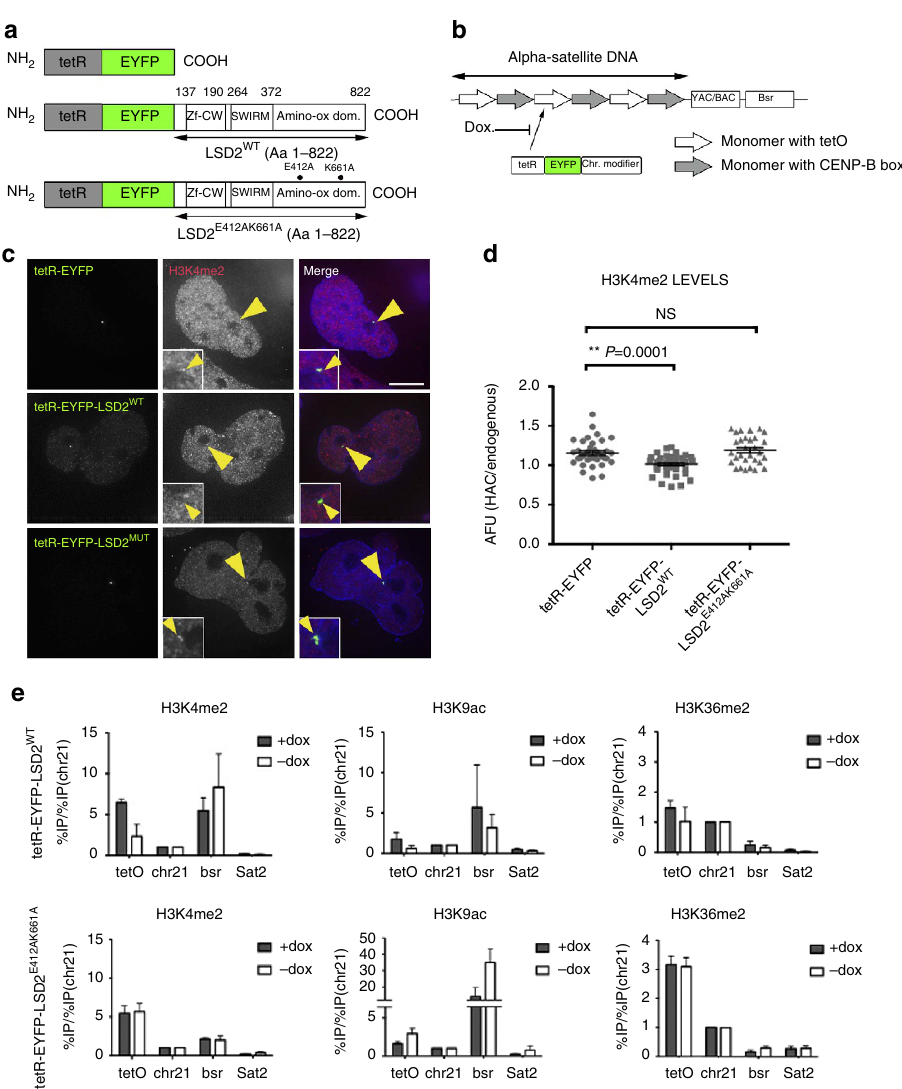
Figure 1 | Tethering LSD2 to the alphoid tetO HAC decreases the H3K4m2 levels. ( a ) Schematic drawings of the tetR-fusion constructs. ( b ) Schematic of the alphoid tetO DNA array, derived from Nakano et al. 27 . ( c ) Immunofluorescence images of 1C7 cells expressing the indicated tetR-fusion proteins and staining for H3K4me2. Arrowheads depict the HAC as determined by the EYFP signal. Scale bar, 10 m m. ( d ) Quantification of fluorescence signals of HAC- associated H3K4me2 staining in individual cells transfected as in C plotted as arbitrary fluorescence units (AFU). Solid bars indicate the medians of three independent experiments and error bars represent the s.e.m. ( e ) ChIP analysis in 1C7 cells expressing tetR-EYFP-LSD2 WT (top) or tetR-EYFP- LSD2 E412AK661A (bottom) using the indicated antibodies. Data represents the levels of the indicated epigenetic marks in the presence of dox (grey bars) and after 3 days of dox washout (white bars). The alphoid tetO HAC centromere (tetO), endogenous chromosome 21 centromere (chr21), the blasticidin resistance gene (bsr) and the degenerate satellite type-II (Sat2) repeats were assessed. Values were normalized to the chromosome 21 centromere and data represent the mean and s.d. of three independent experiments. Asterisks indicate a significant difference ( P o 0.05; Mann–Whitney’s test).